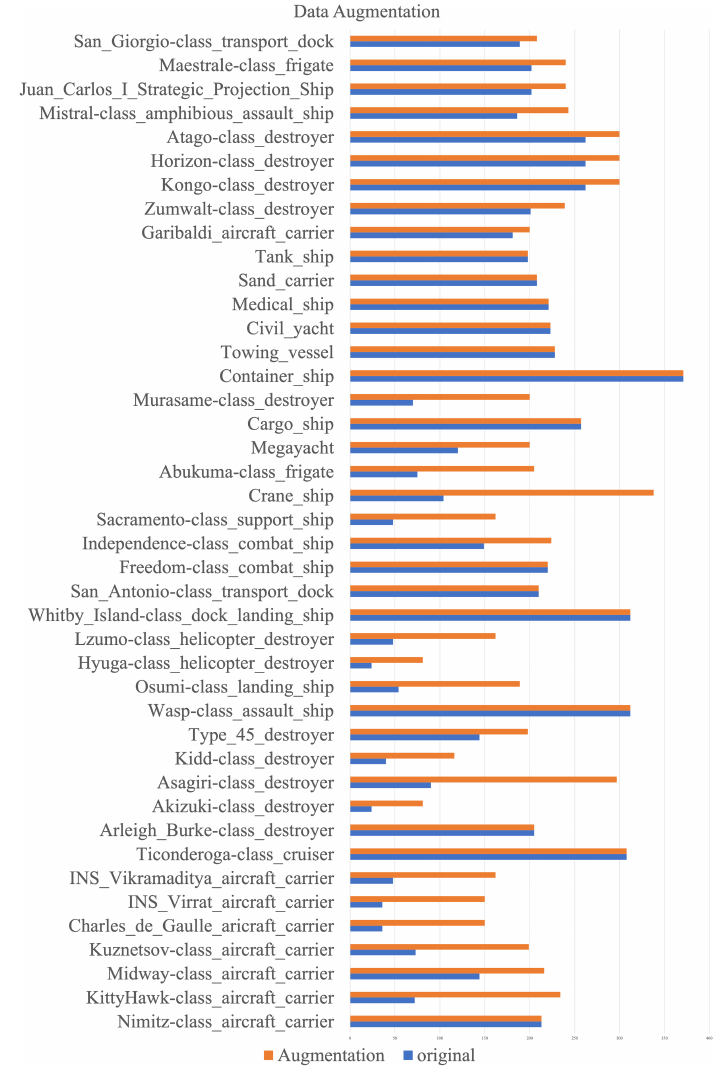
Figure 4. Comparison of each category of FGSCR-42 between the image numbers after